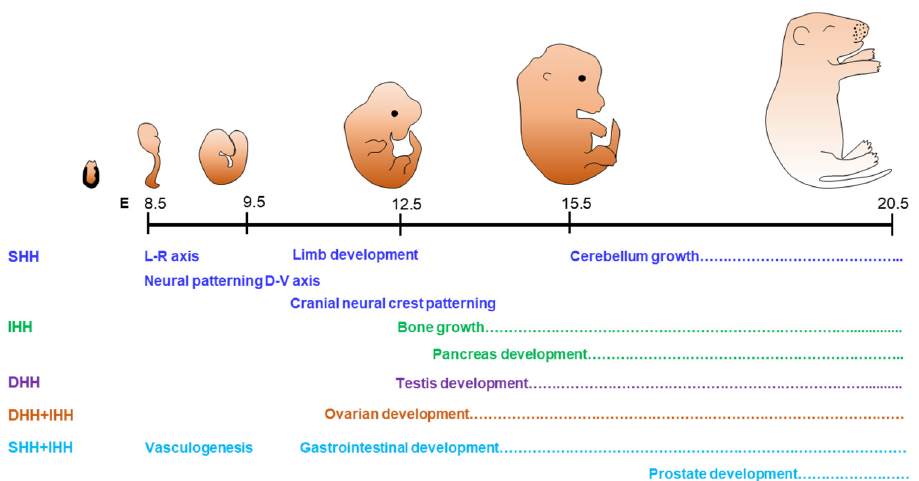
Figure 1. Role of hedgehog signaling in organogenesis. Hedgehog (HH) signaling is highly conserved across species and plays a major role in organogenesis during the embryonic life. The schematic presentation shows the days in mouse embryonic development (considering the day of mating plug positive as E0.5). Name of the functions and the dotted lines indicate the duration in embryonic days when SHH, IHH, and DHH control the developmental processes. Both IHH and DHH play an important role in the development of gonads, while SHH and IHH contributes to vasculogenesis, gastrointestinal development, and the development of prostate gland.